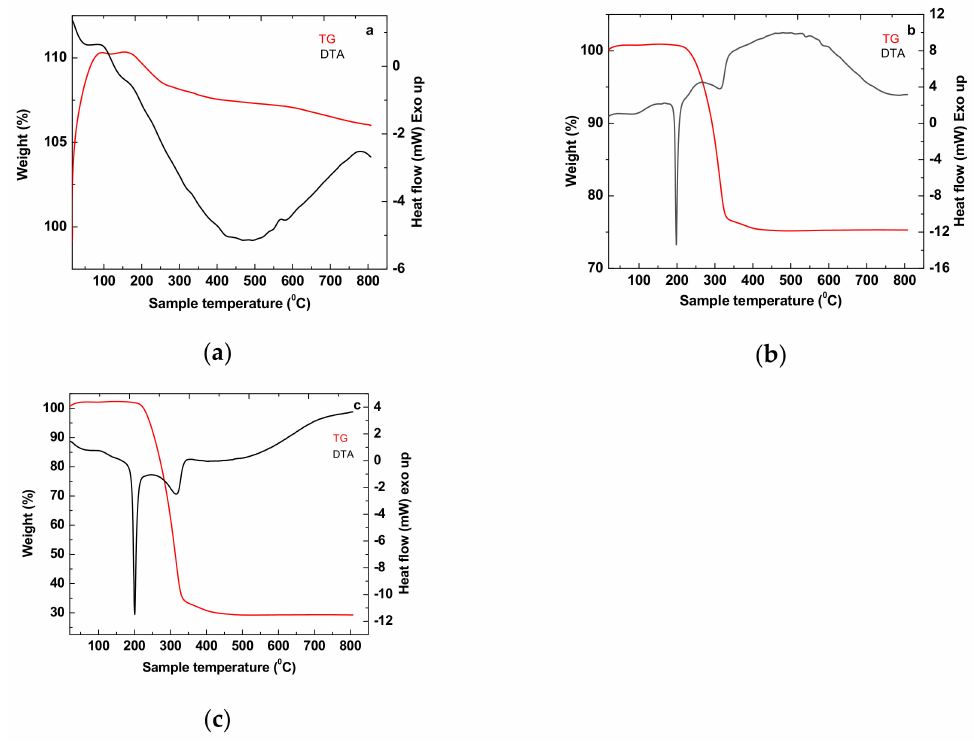
Figure 4. TG-DTA curves of the RGO sheets ( a ), 5A1N ( b ) and the 5A1N / RGO composite ( c